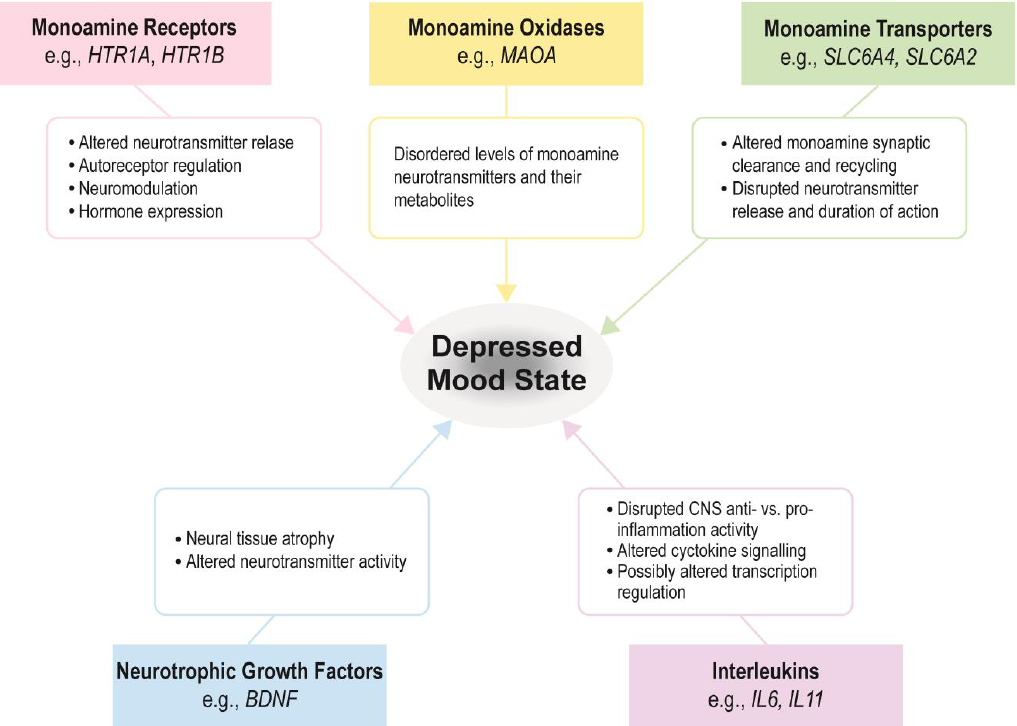
Figure 1. Plausible biologic mechanisms by which products of genes that have been studied in the context of antidepressants and DNA methylation contribute to depressed mood pathology.